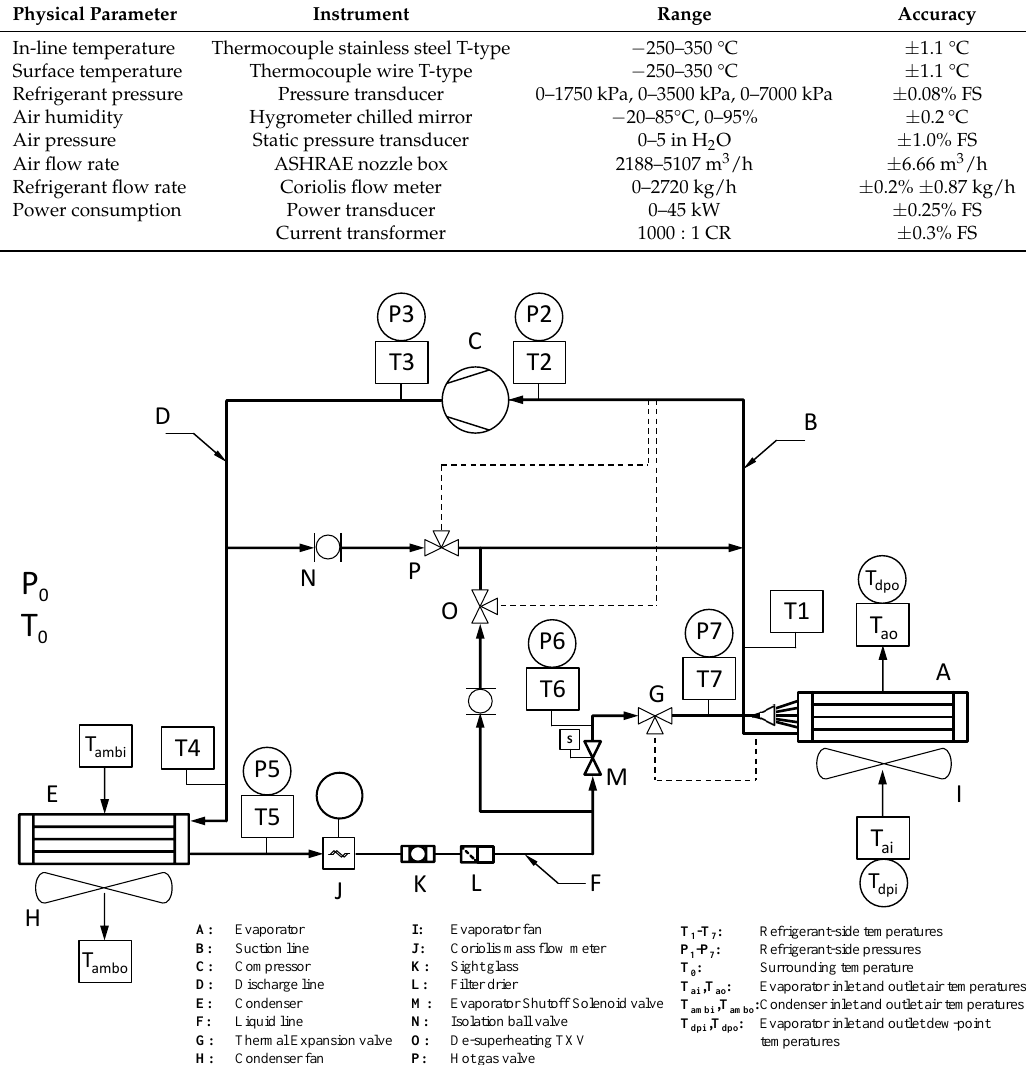
Figure 3. The measured points of